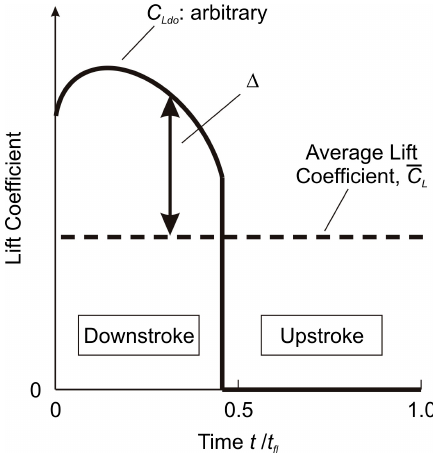
Figure 5. Time history of lift coefficient during wing stroke.